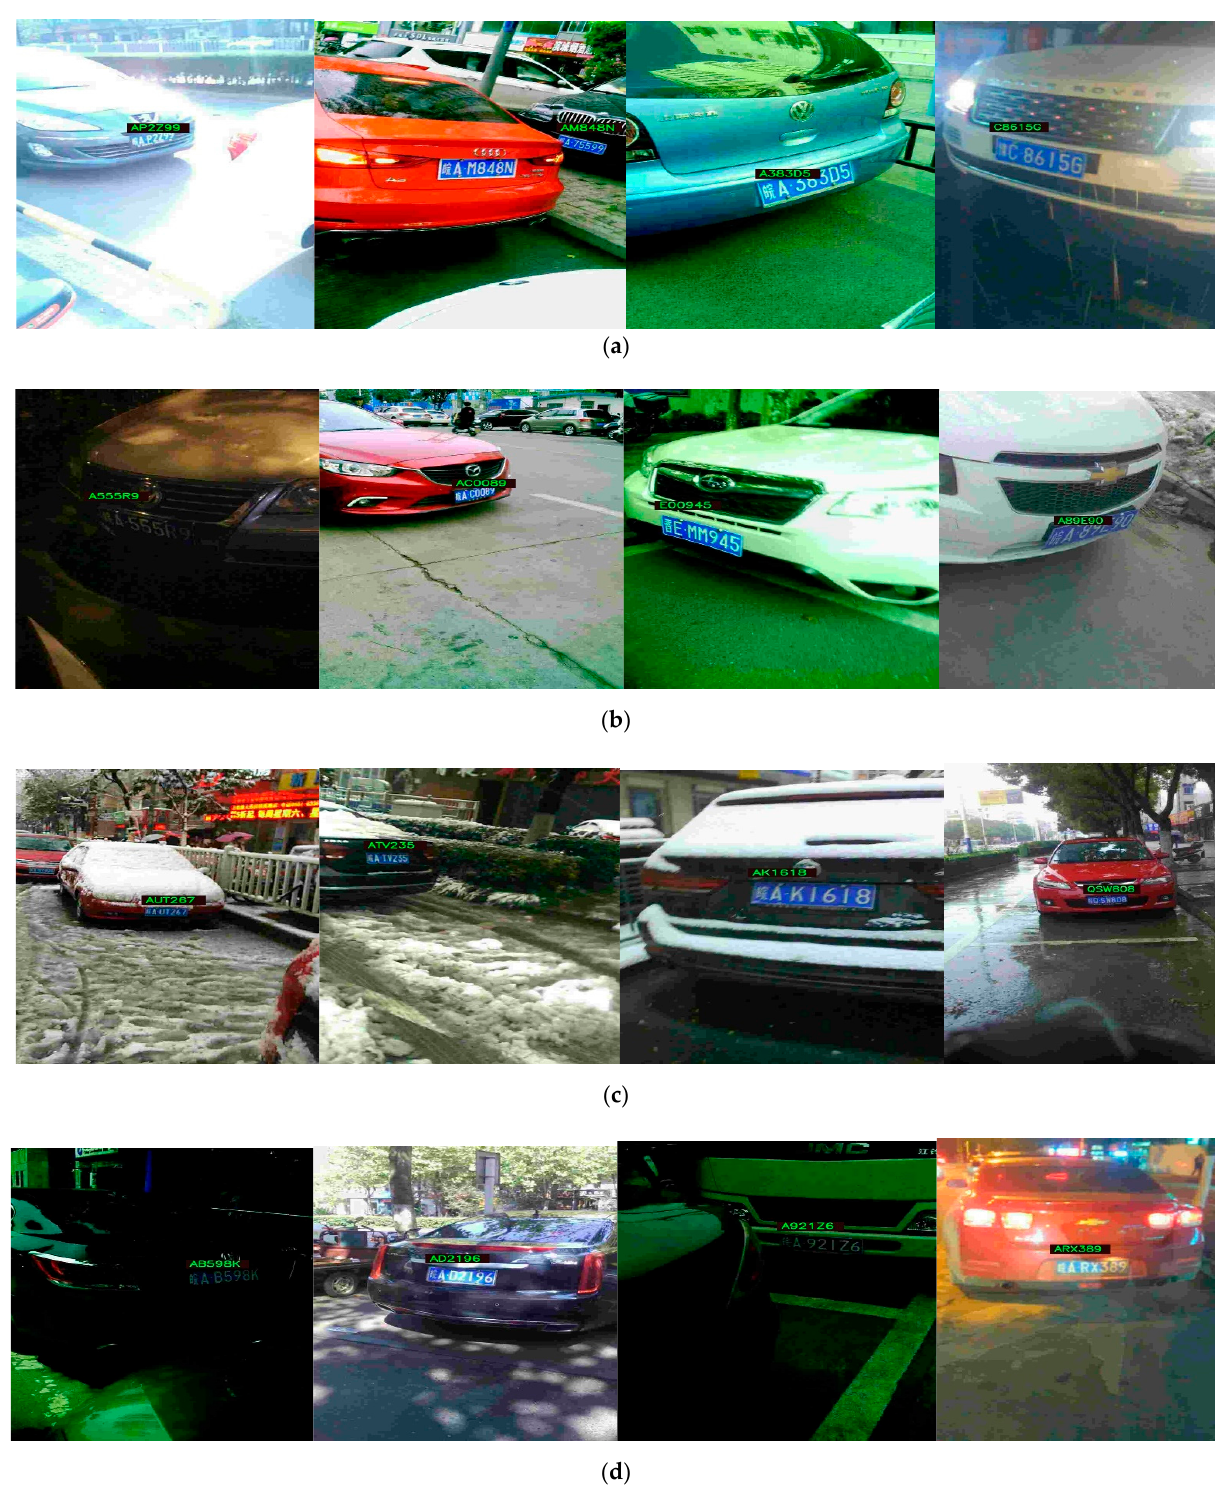
Figure 8 . The LPR on the CCPD includes ( a ) rotate, ( b ) tilt, ( c ) weather, and ( d ) challenge scenarios. More output resultant images from the CCPD dataset are shown in the third row of Figure 8, where a few cases are shown for the di ff erent weather conditions. The fi rst three